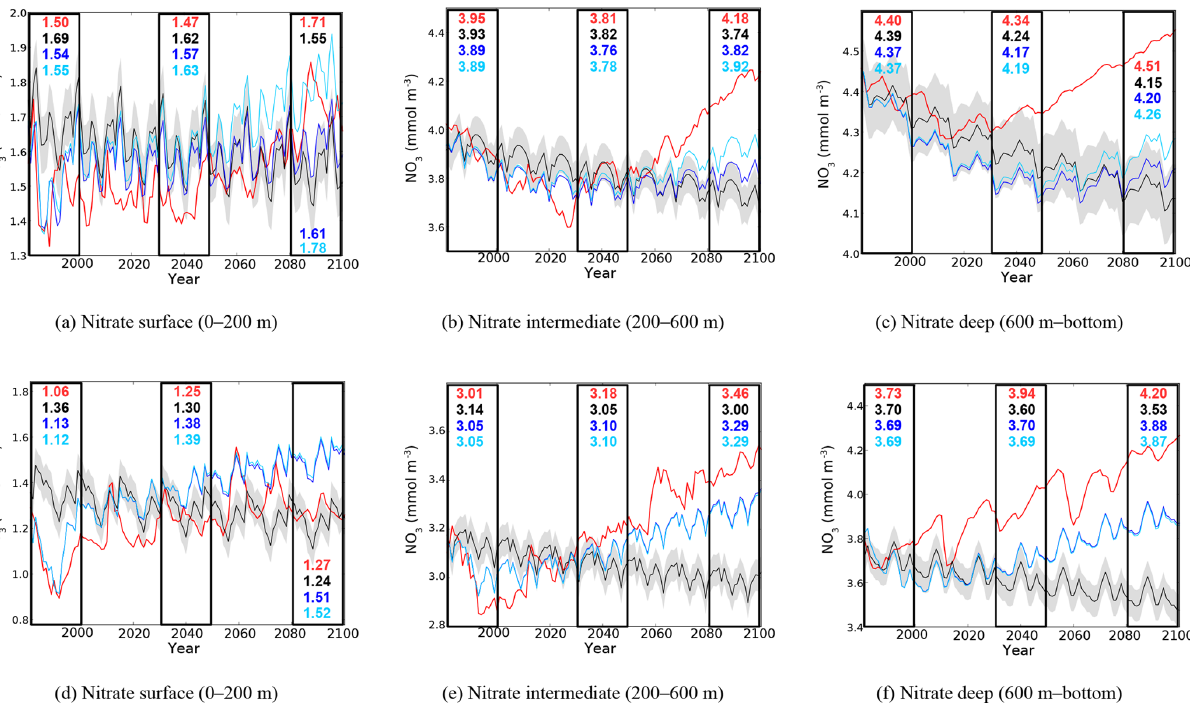
Figure 8. Evolution of yearly average nitrate concentration (10 − 3 molm − 3 ) in the surface (a, d) , intermediate (b, e) , and bottom (c, f) layers in the western (a, b, c) and eastern (d, e, f) basins. Red lines represent the HIS/A2 simulation, black lines represent the CTRL (with standard deviation), and blue and light blue lines represent the CTRL_R and CTRL_RG simulations respectively. Colored numbers in the highlighted areas represent the average concentrations in the corresponding simulations for the highlighted time